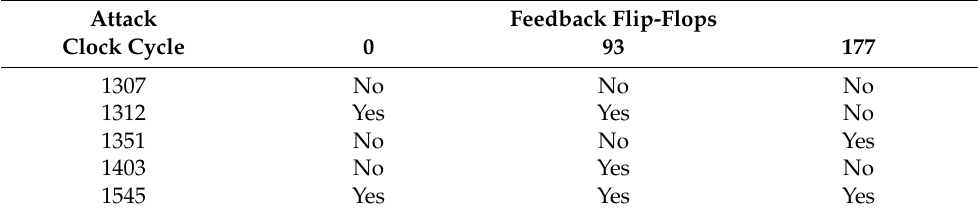
Table 4. Transition values of the standard Trivium feedback flip-flops.